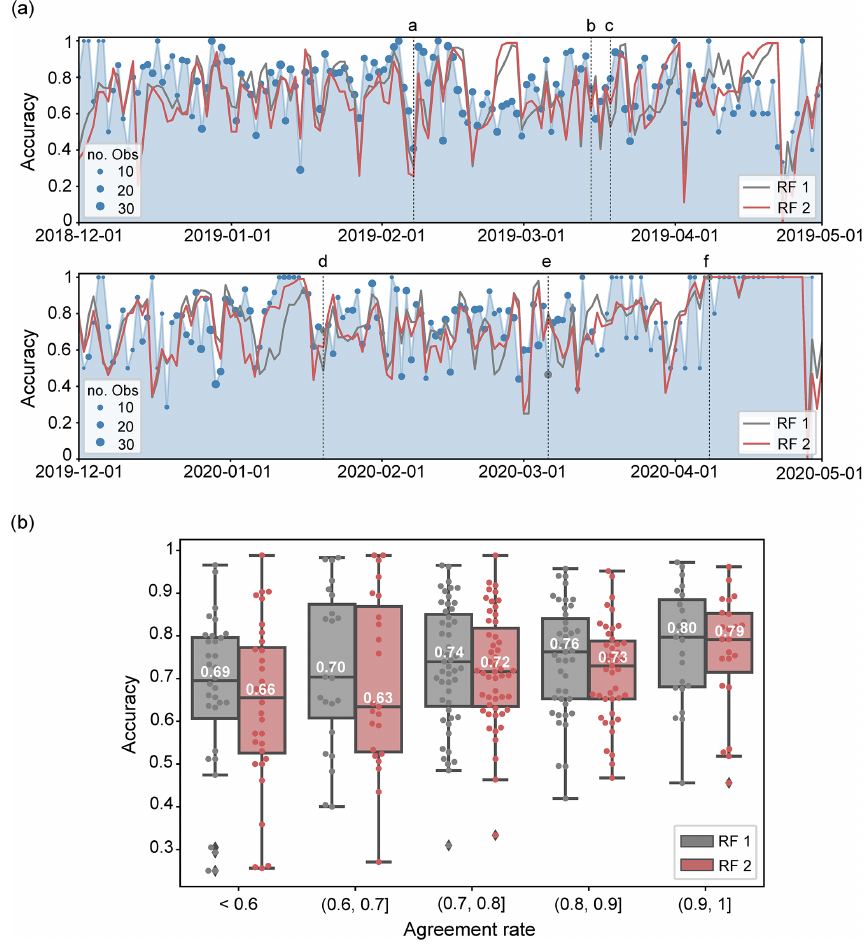
Figure 7. (a) Comparison of the time series of the daily accuracy of the two random forest models, RF 1 (trained with D forecast ) and RF 2 (trained with D tidy ), tested on the winter seasons of 2018/19 (top) and 2019/20 (bottom) for predicting the danger level forecasts. The blue- shaded area represents the agreement rate, and the points show the number of observers that provided an assessment. The dashed lines show the six dates (labelled from a to f) selected as exemplary cases (see Appendix D). The date is indicated in the format year-month-day. (b) Box plots of the distribution of the accuracy of the models, grouped together by the agreement rate. Dots are the individual data